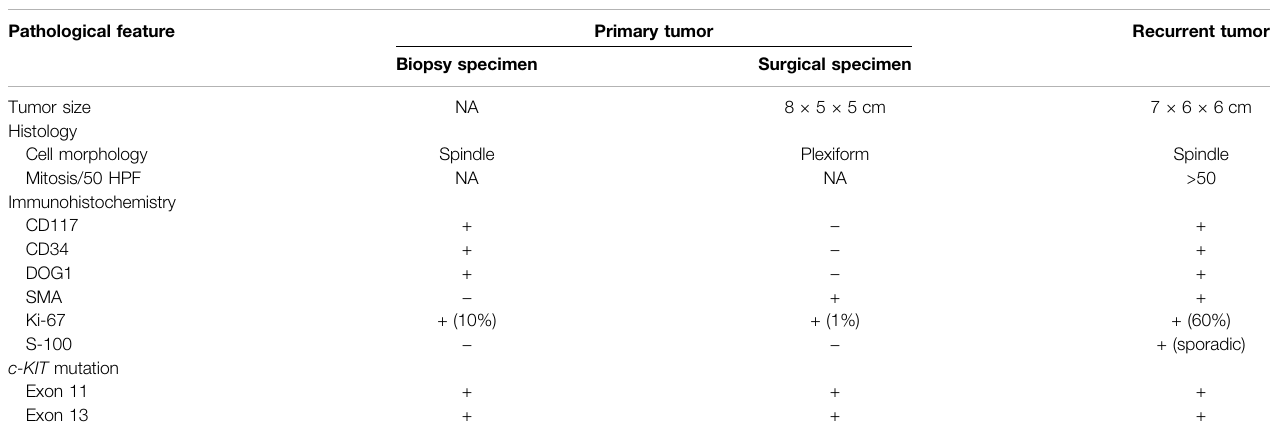
TABLE 2 | Clinical and pathological characteristics in the GIST patient. Pathological